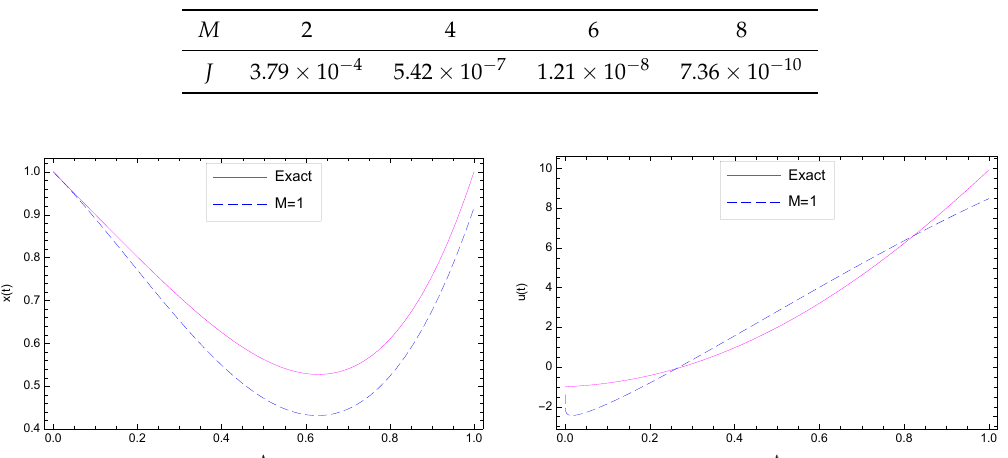
Table 4. (Example 3.) Numerical results for the performance index obtained by Approach II with different M .